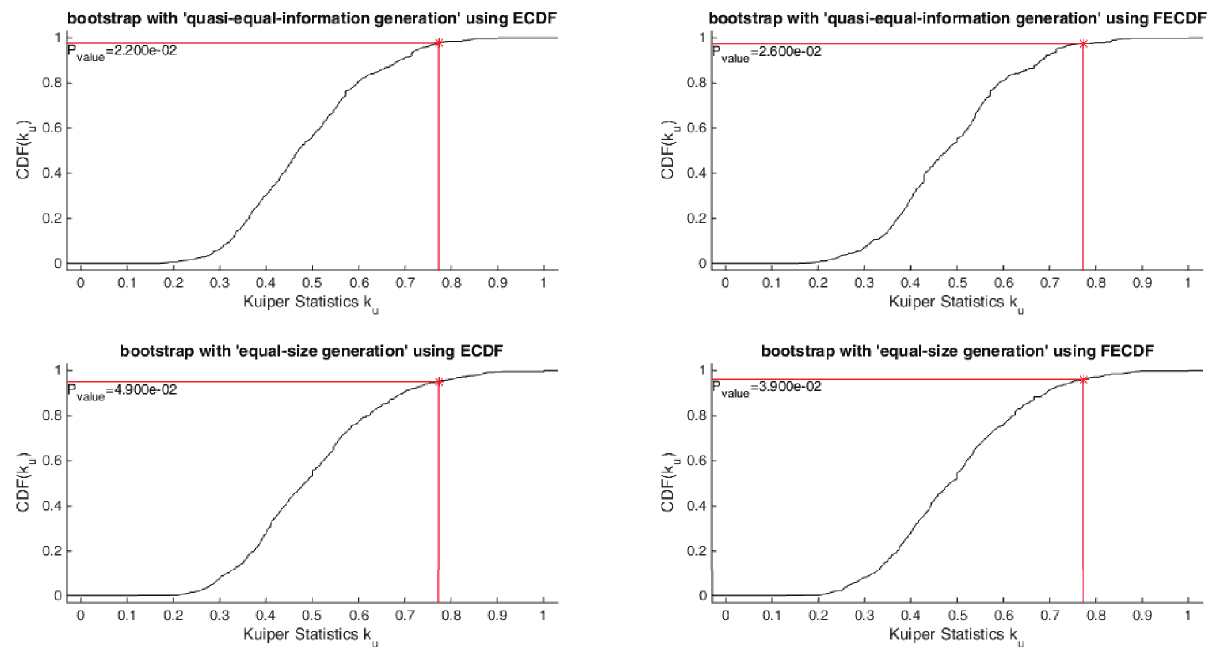
Fig. 6. Bootstrap generated CDFs of the Kuiper's statistic for the fuzzy samples in Numerical example